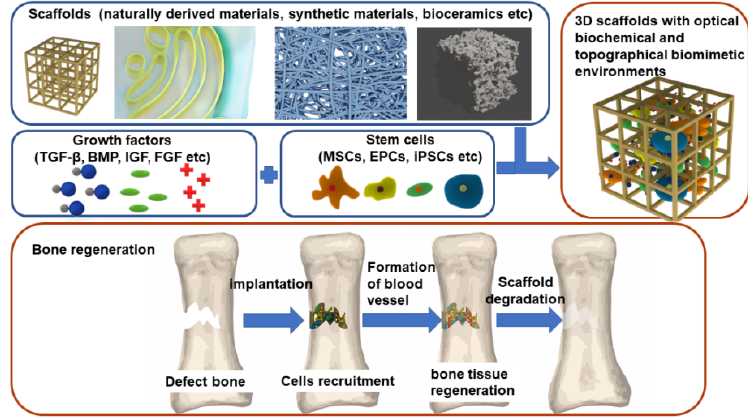
Figure 1. The components of BTE and the process of bone